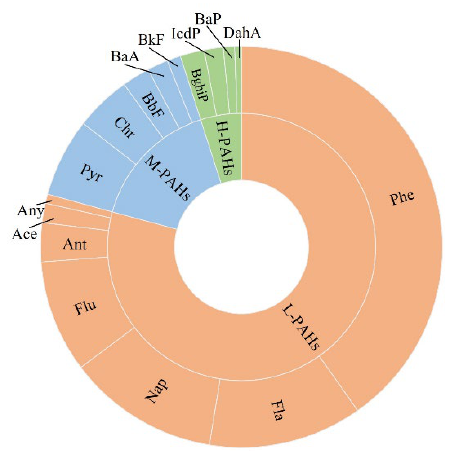
Figure 5. Total contents of PAHs in Poaceae (n = 16) and Compositae (n = 19) plants near 9 lakes. The 16 PAHs in plants were dominated by Phe (40.2%), followed by Fla, Nap, and Flu, similar to the distribution of PAHs in the soil. DahA, Ace, and BaP accounted for relatively low proportions (all less than 1%) (Figure 6). Low-molecular-weight PAHs accounted for the highest proportion (79.2%), followed by medium-molecular-weight PAHs. High-molecular-weight PAHs accounted for the least proportion, which is consistent with composition of the soil.